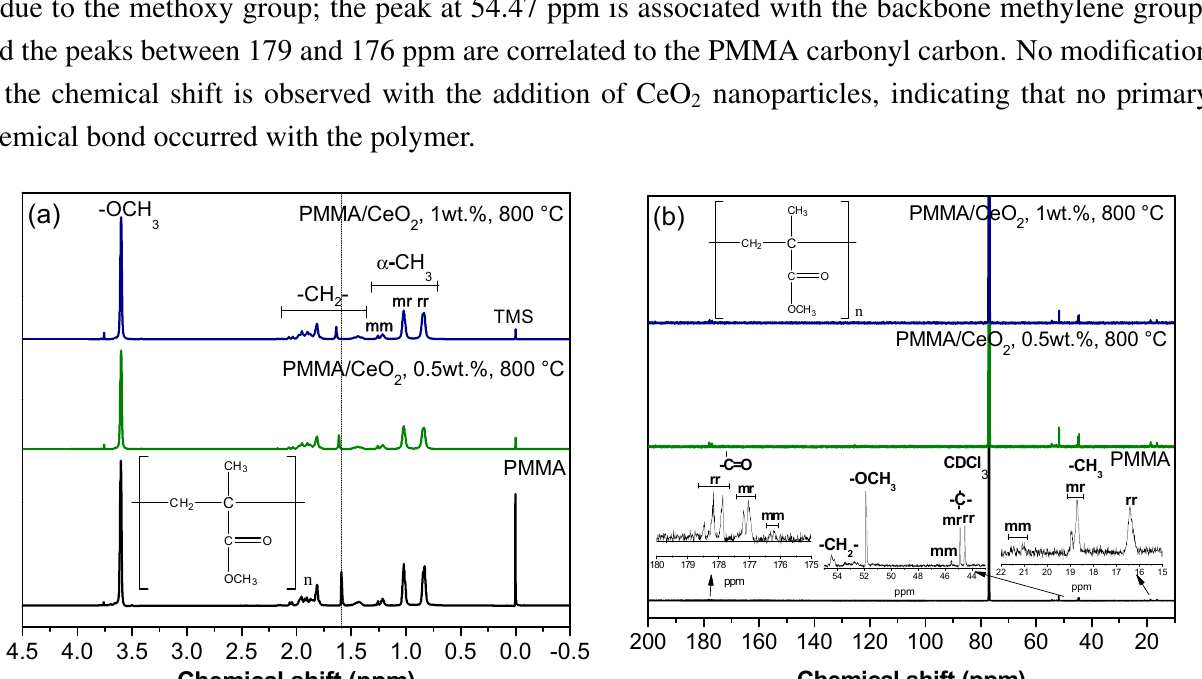
Figure 2. NMR spectra of pure PMMA and PMMA/CeO 2 hybrid systems by ( a ) 1 H NMR and ( b ) 13 C NMR.